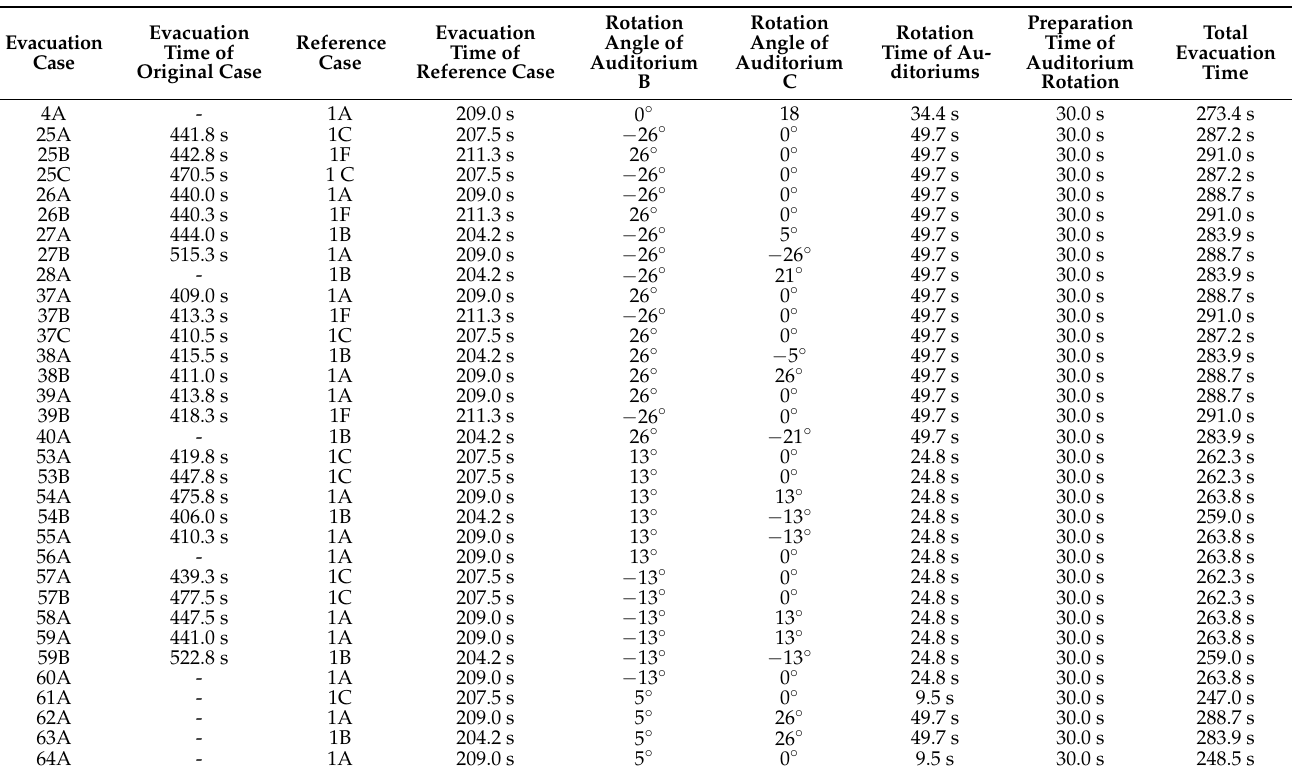
Table 10. Details of evacuation time for each case where the evacuation exit is